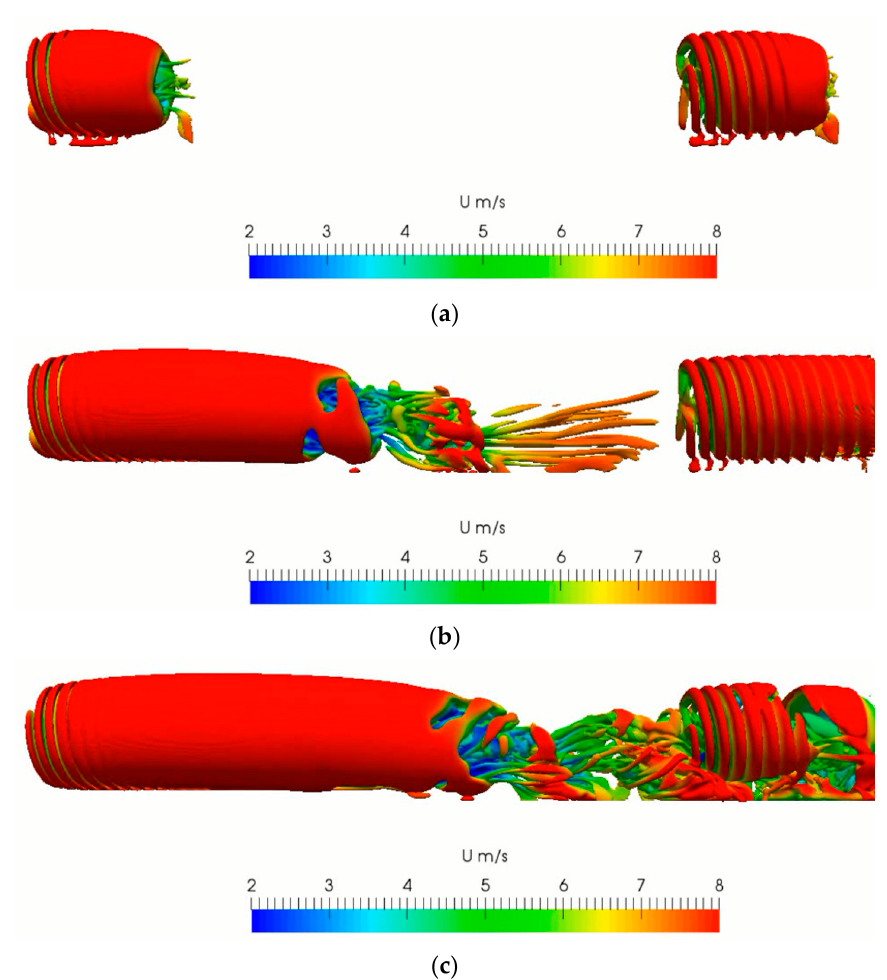
Figure 24. The wake structure development of double wind turbine aligned: ( a ) initial status without disturb; ( b ) developing status; and ( c ) interference status.